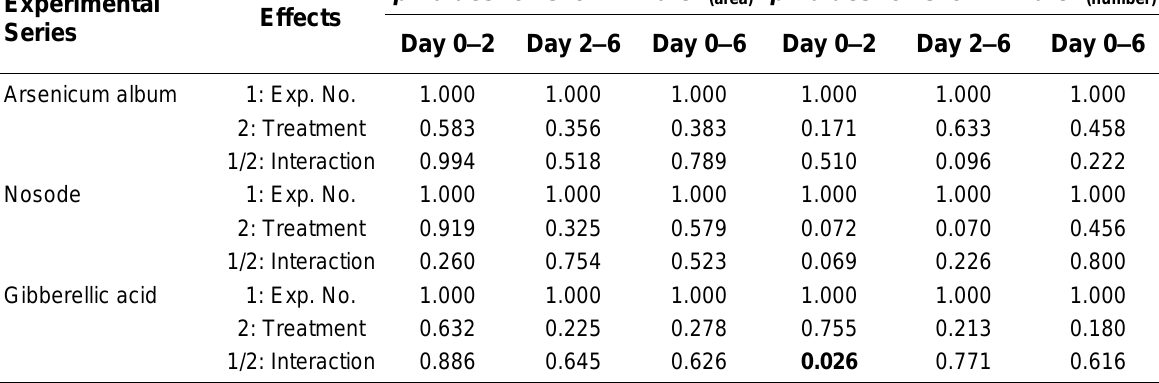
Comparison (ANOVA F -Tests) of Unsuccussed (c0) and Succussed (c1) Controls by Two Growth Parameters in Three Time Intervals (Days 0 – 2, 2 – 6, 0 – 6)